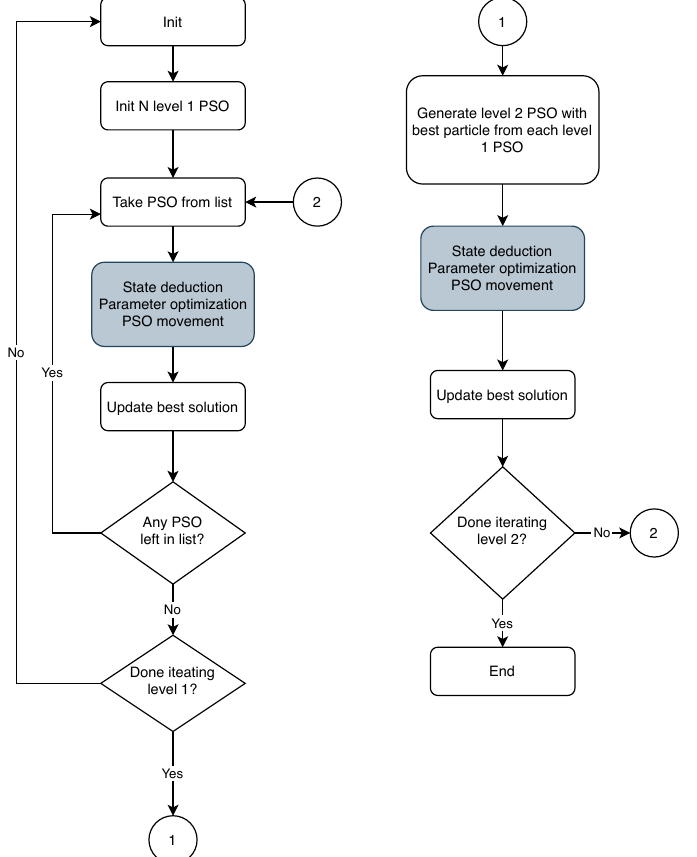
Figure 5. PSO algorithm state deduction integration.